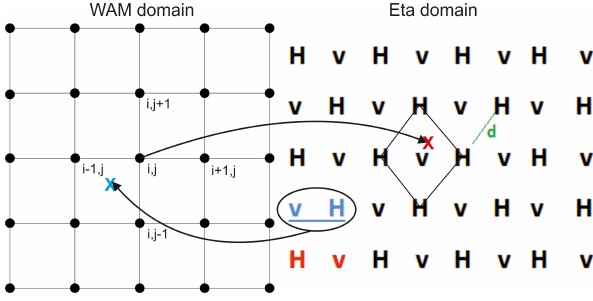
Figure 4. Sketch of the WEW multi-grid structure. The transforma- tions from the Arakawa E grid to the regular lat–long grid and vice versa are also